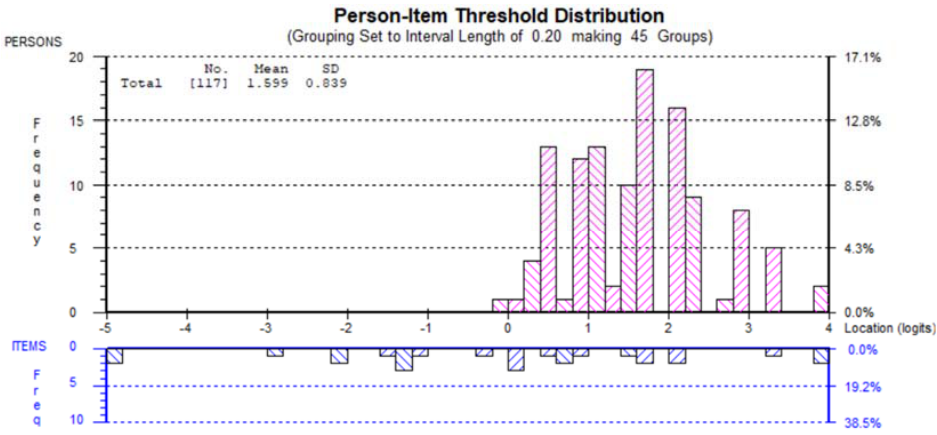
Figure 2. Threshold map after collapsing middle categories, notice that “Eat 3 main meals” is still disordered.